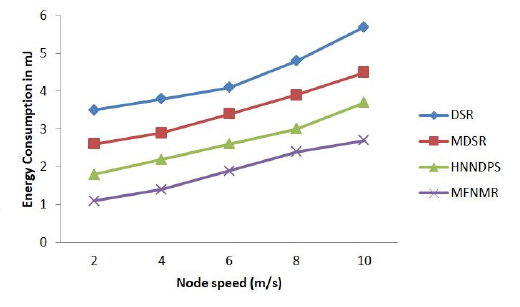
Figure 8. Energy Consumption Analysis based on Node Speed.